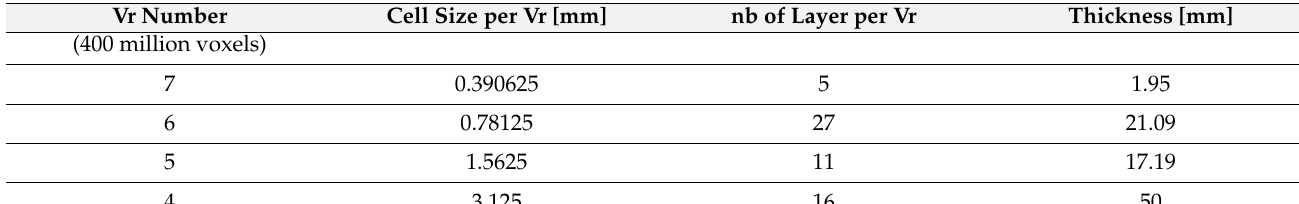
5 of 16 Table 1. Boundary layer definition for the mesh of 50 million voxels and 400 million voxels (right) according to their voxel refinement (Vr) distribution. Vr Number